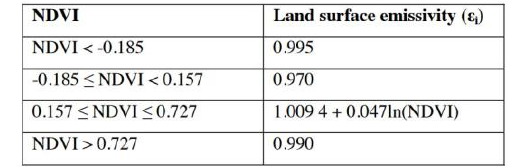
Table 1. Relation between the Normalized